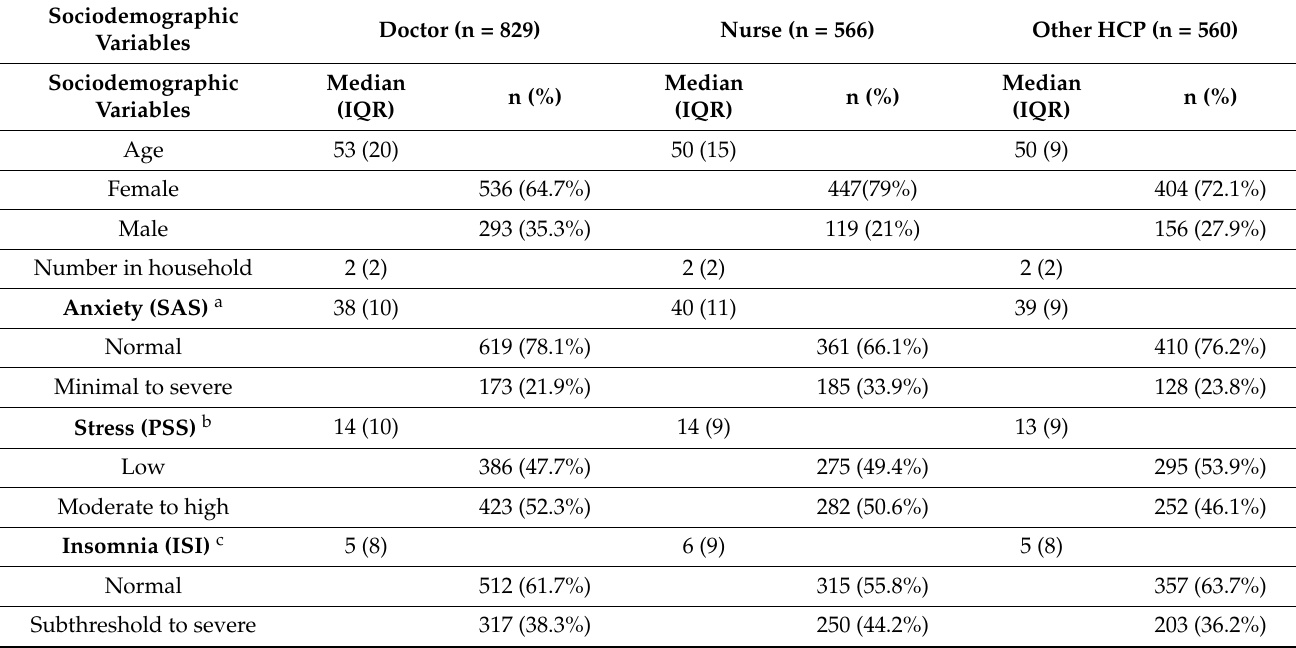
Table 1. Sociodemographic and mental health outcomes during the first wave (post 11